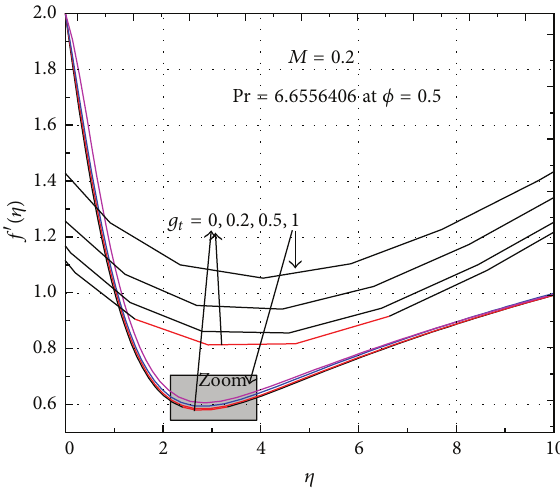
Figure 6: Effect of temperature buoyancy parameter on velocity.